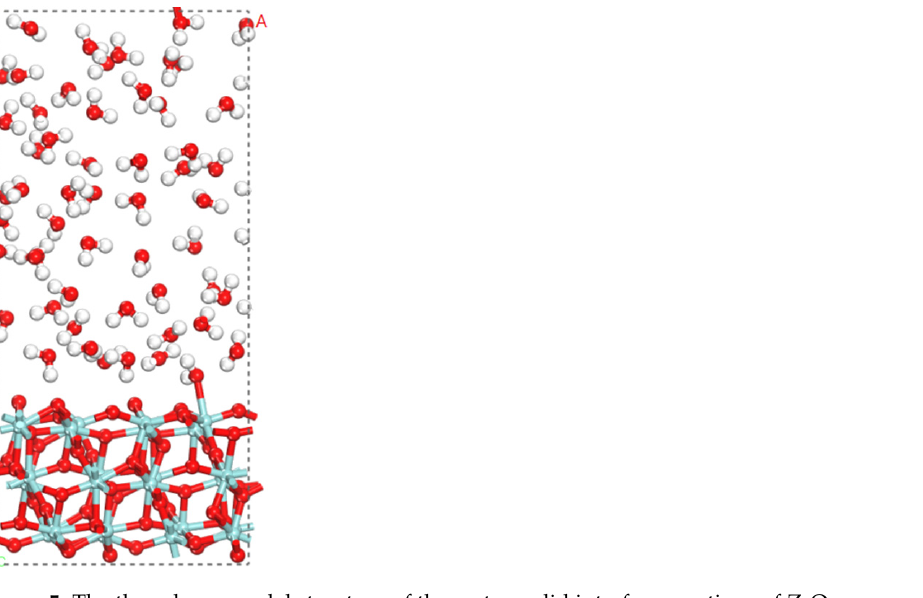
the radial distribution functions (RDFs) and their integrated RDFs for H and O in water molecules and for the Zr atom on the ZrO 2 surface were calculated. The RDF g( r ) is the distribution probability of a given particle α over a particle β when the distance is r . As shown in Figure 6, the first peak in g( r ) H – H appears around 1.5 Å, showing H – H interactions between the same water molecules. The second peak in g( r ) H – H appears around 2.3 Å, showing the interaction between H atoms of different water molecules. The first peak in g( r ) O* – H is 1.0 Å and corresponds to the O – H bond. The second peak in g( r ) O* – H appears at 1.6 – 2.1 Å, which shows strong hydrogen bonding between the H and O atoms in different water molecules. The first peak of g( r ) Zr* – O* is 2.15 Å and corresponds to the interaction between the Zr atom on the surface and the O atom in a water molecule, which also indicates that the water molecules are strongly adsorbed and dissociated on the ZrO 2 surface. The value of the integral RDF corresponding to the first peak of g( r ) Zr* – O* is 0.9, indicating that the first coordination layer of the Zr atom on the surface has 0.9 O atoms and the Zr atom has approximately one water molecule adsorbed on it. The peak of g( r ) O** – H between O atoms on the surface of ZrO 2 and H atoms in the water molecule is about 1.0 Å and further indicates hydroxyl ( – OH) formation on the ZrO 2 surface. The value of the integrated RDF corresponding to the first peak of g( r ) O** – H indicates that the first coordination layer of the O atom has 0.4 H atoms on the surface. All these results above show that the water molecules mainly interact with each other via hydrogen bonding. The water molecules close to the surface will be strongly adsorbed at the Zr atoms on the surface to form Zr – O bonding sites. Meanwhile, the H atoms of some water molecules are dissociated to form O – H bonds with the O atoms on the surface.